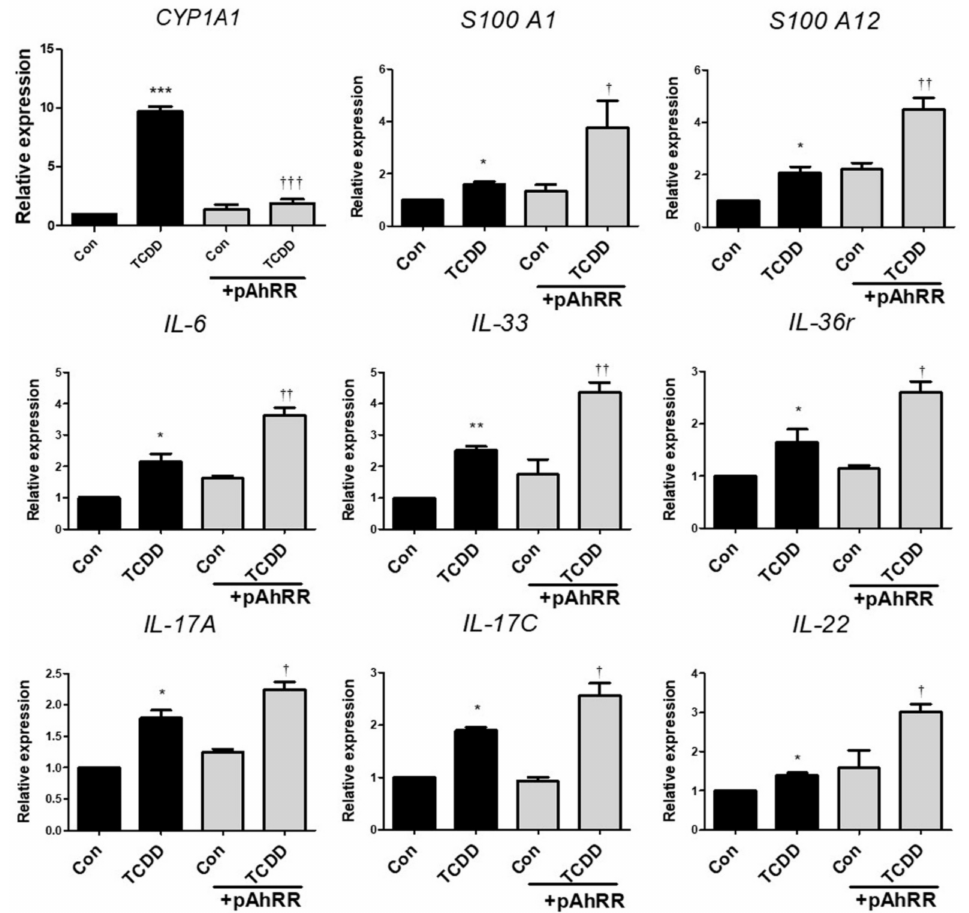
Figure 4. Effect of AhRR overexpression on pro-inflammatory cytokine expression in HaCaT cells. Pro-inflammatory cytokine expression mRNA expression in HaCaT cells was examined by qPCR. Values are means ± SEM. Statistical significance of differences between groups was assessed by one- way analysis of variance (ANOVA) for factorial comparisons and by Tukey’s multiple comparison tests for multiple comparisons. All experiments were performed in at least three independent experiments. * p < 0.05 vs. control, ** p < 0.01 vs. control, *** p < 0.001 vs. control, † < 0.05 vs. TCDD, †† < 0.01 vs. TCDD, ††† < 0.001 vs.